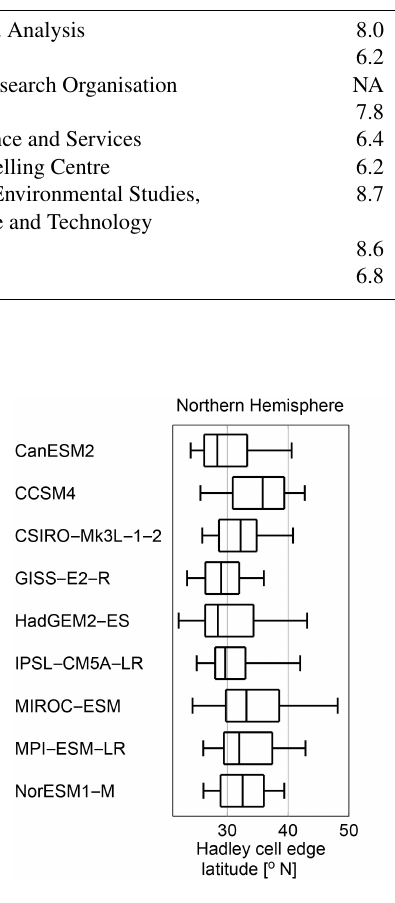
Figure 1. The piControl experiment climatology of the tropical belt edge latitudes for each of the nine models. The middle bar of each box represents the median, and the left and right bars of each box represent the lower and upper quartiles, respectively, of the tropical belt edge latitudes. Whiskers indicate the maximum and minimum tropical belt edge latitude for the piControl